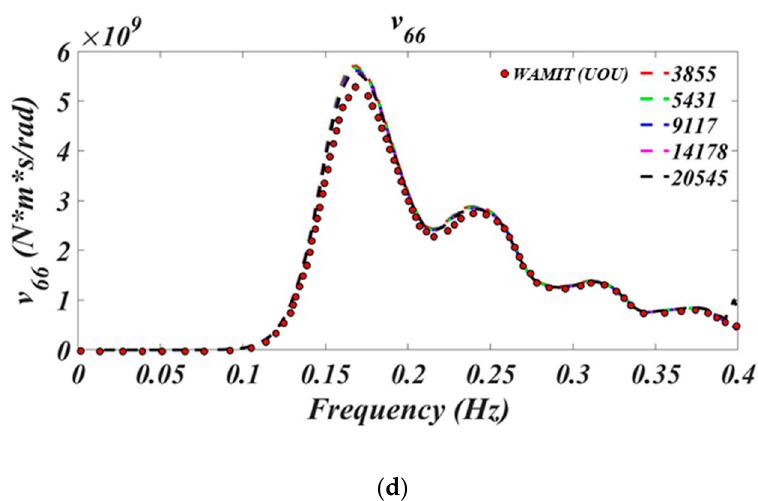
Figure 9. The comparison of damping coefficients between different mesh numbers and the UOU data in ( a ) surge and sway, ( b ) heave, ( c ) roll and pitch, and ( d ) yaw modes